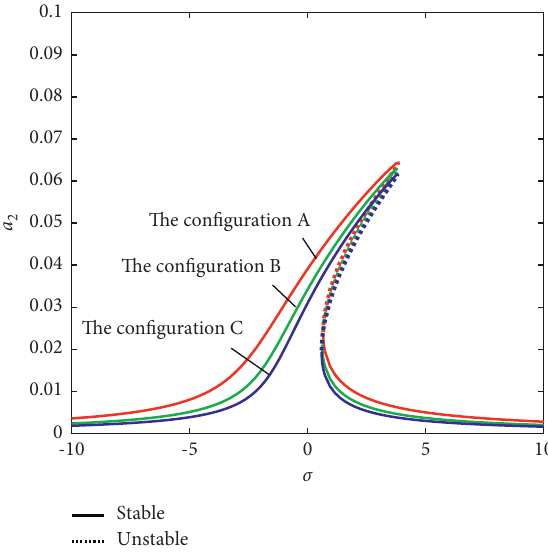
Figure 31: The effect of ply angle on frequency response curve (L/d � 10, c � 0.01, case II).